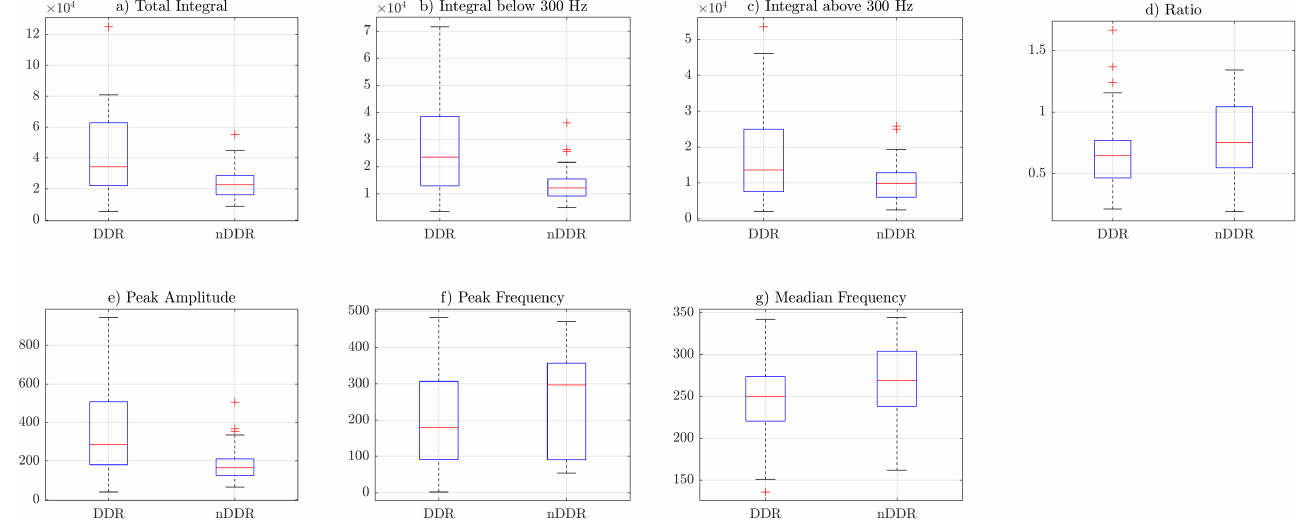
Figure A6. Box plots of norm2 features obtained for the second measurement: ( a ) TI feature, ( b ) IB3 feature, ( c ) IA3 feature, ( d ) IBAR feature, ( e ) PA feature, ( f ) PF feature, ( g ) MF